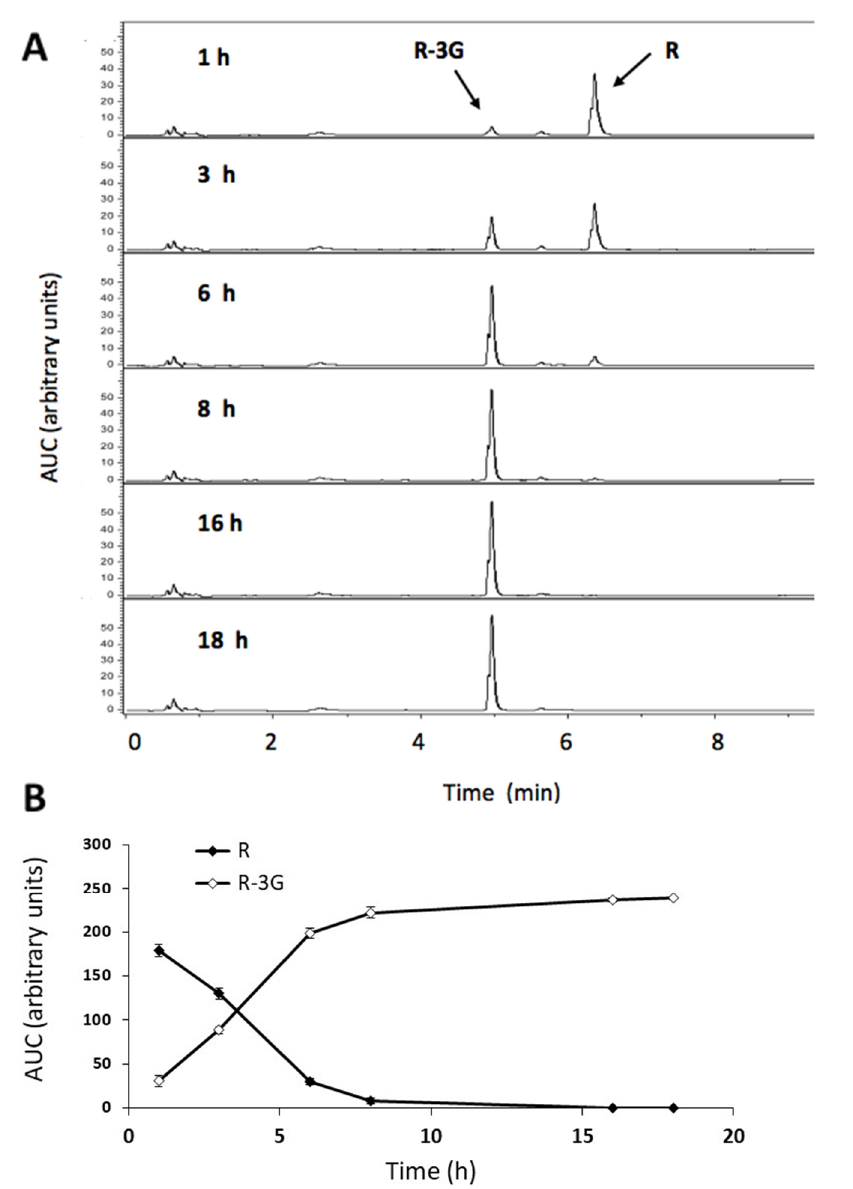
Figure 3. UHPLC-UV profile of resveratrol (R) and trans-resveratrol-3- O - β - D -glucuronide (R-3G) in the AML12 hepatocyte incubation media. The chromatograms show the metabolism of R into R-3G in the steatotic AML12 incubation media of cells exposed to 0.3 M palmitic acid (PA) and R (25 µM) at 1, 3, 6, 8, 16 and 18 h of incubation ( A ). Amount of R and R-3G in the AML12 hepatocytes incubation media over 18 h ( B ).